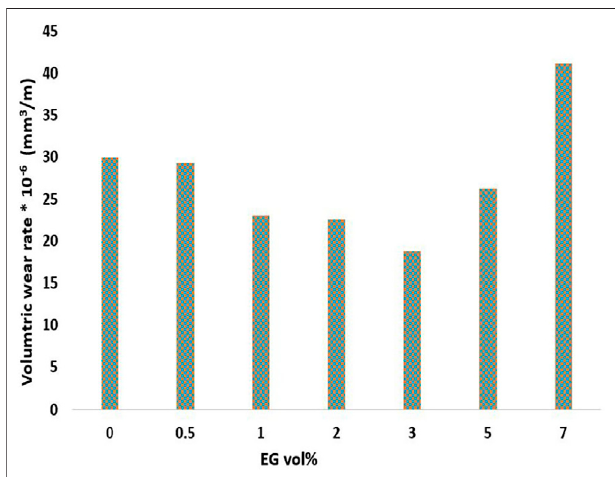
FIGURE 6 | Volumetric wear rate of the neat PEEK and the PEEK/EG